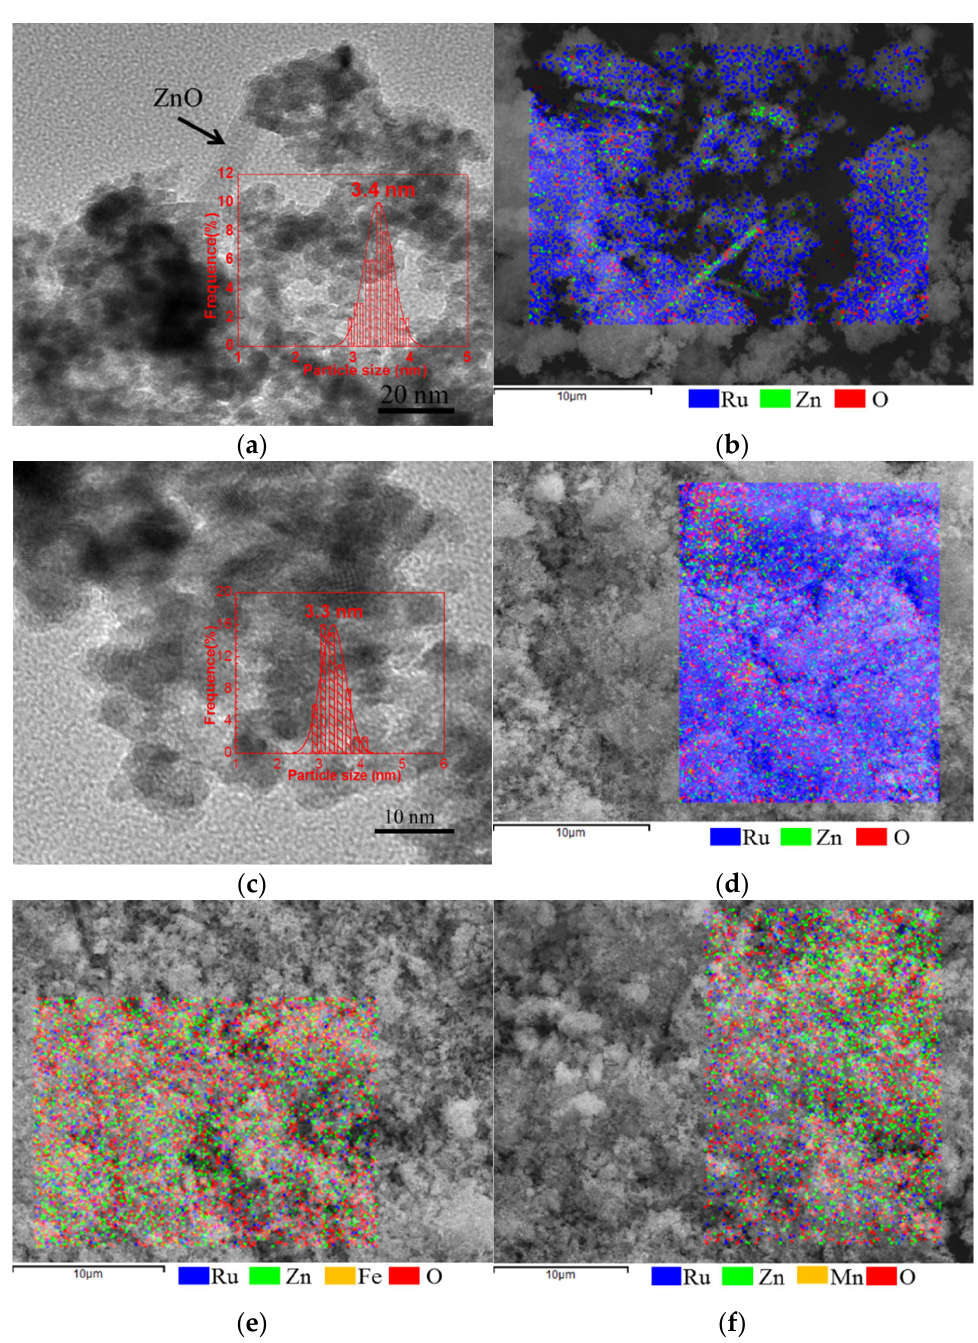
Figure 7. TEM images, SEM images, particle size distribution, and element mapping image of the spent Ru ‐ Zn catalyst with different reaction modifiers added. ( a ) TEM image and particle size dis ‐ tribution (insert image) of the spent Ru ‐ Zn catalyst without using any reaction modifier; ( b ) SEM image as well as element mapping image of the spent Ru ‐ Zn catalyst without using any reaction modifier; ( c ) TEM image of the spent Ru ‐ Zn catalyst applying ZnSO 4 (0.57 mol L − 1 ) as the reaction modifier; ( d ) SEM image as well as the element mapping image of the spent Ru ‐ Zn catalyst using ZnSO 4 as a reaction modifier; ( e ) SEM image as well as the element mapping image of the spent Ru ‐ Zn catalyst using FeSO 4 as a reaction modifier; ( f ) SEM image as well as the element mapping image of the spent Ru ‐ Zn catalyst using MnSO 4 as a reaction modifier.